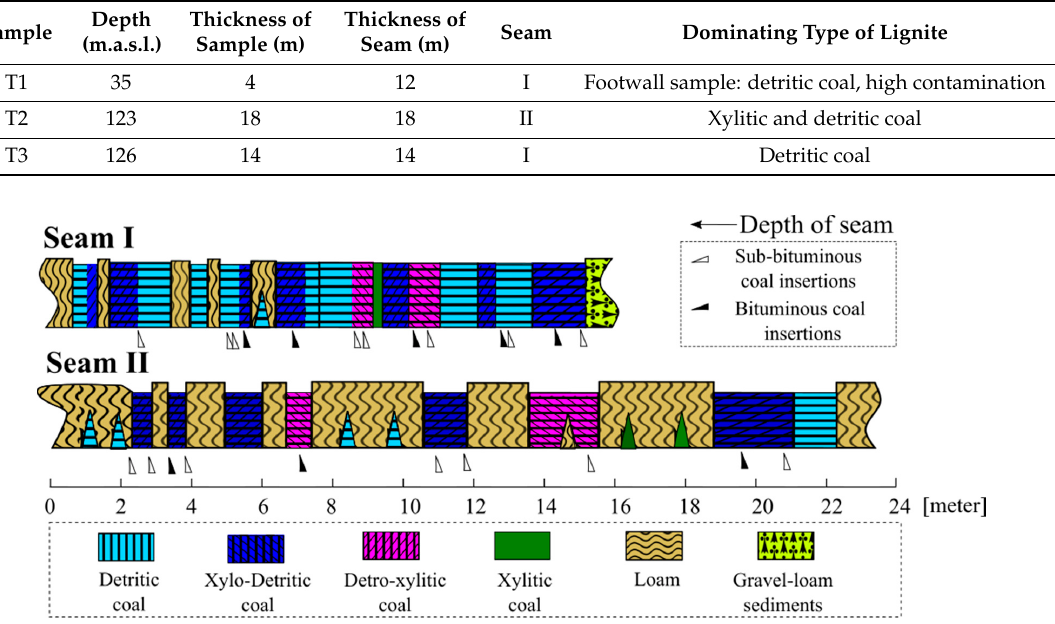
Figure 2. An exemplary of seam’s petrographic profile found in Seams I and II [22]. The profiles were taken in the neighborhood of drilling points of Samples T2 and T3. The locations of the samples taken were correspondingly presented in Figure 1a: the point P1 for Seam I profile and the point P2 for Seam II profile. The variety of petrographic lithotype textures can be